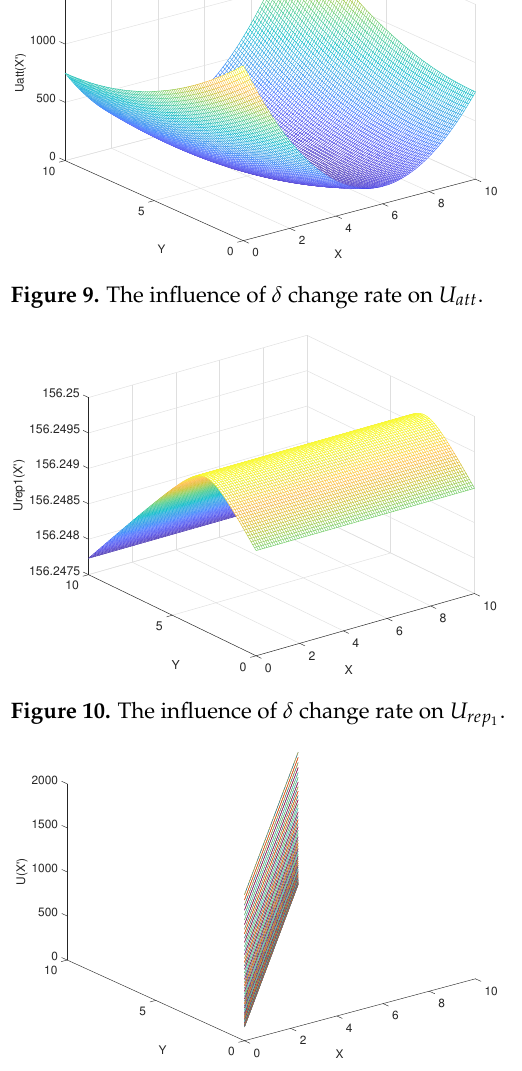
Figure 11. The influence of δ change rate on the resultant force of attraction and